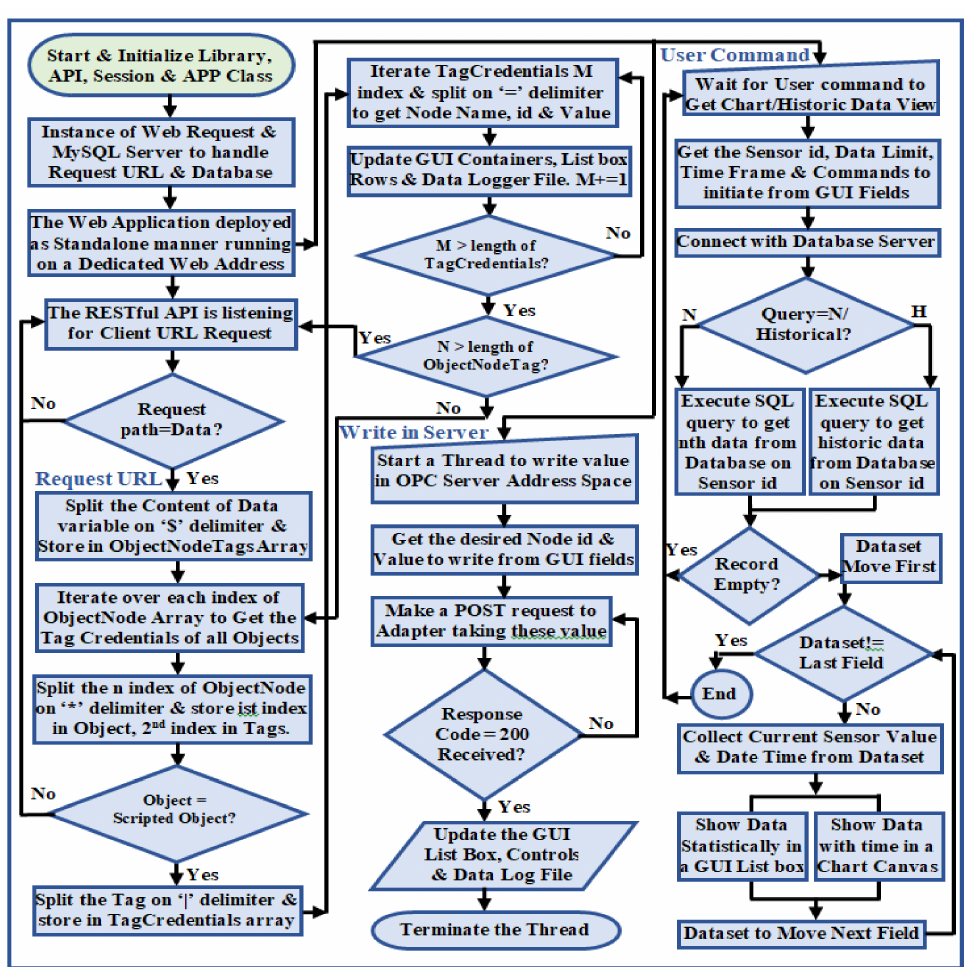
Figure 8. Process flow chart of the developed web service